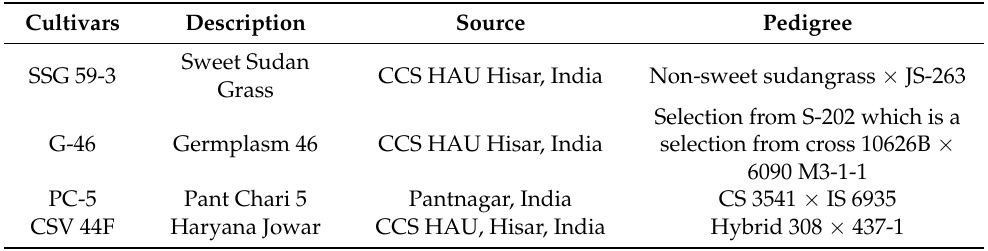
Table 1. Physical characteristics of sorghum